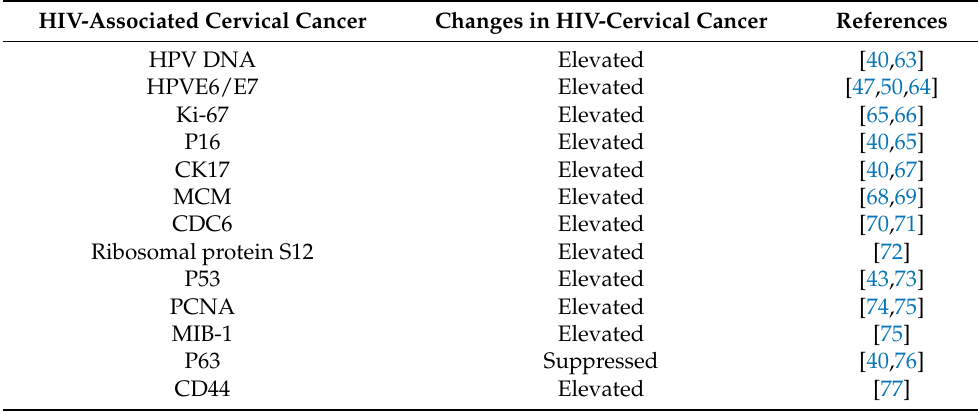
Table 1. Identified biomarkers and the related changes in HIV-associated cervical